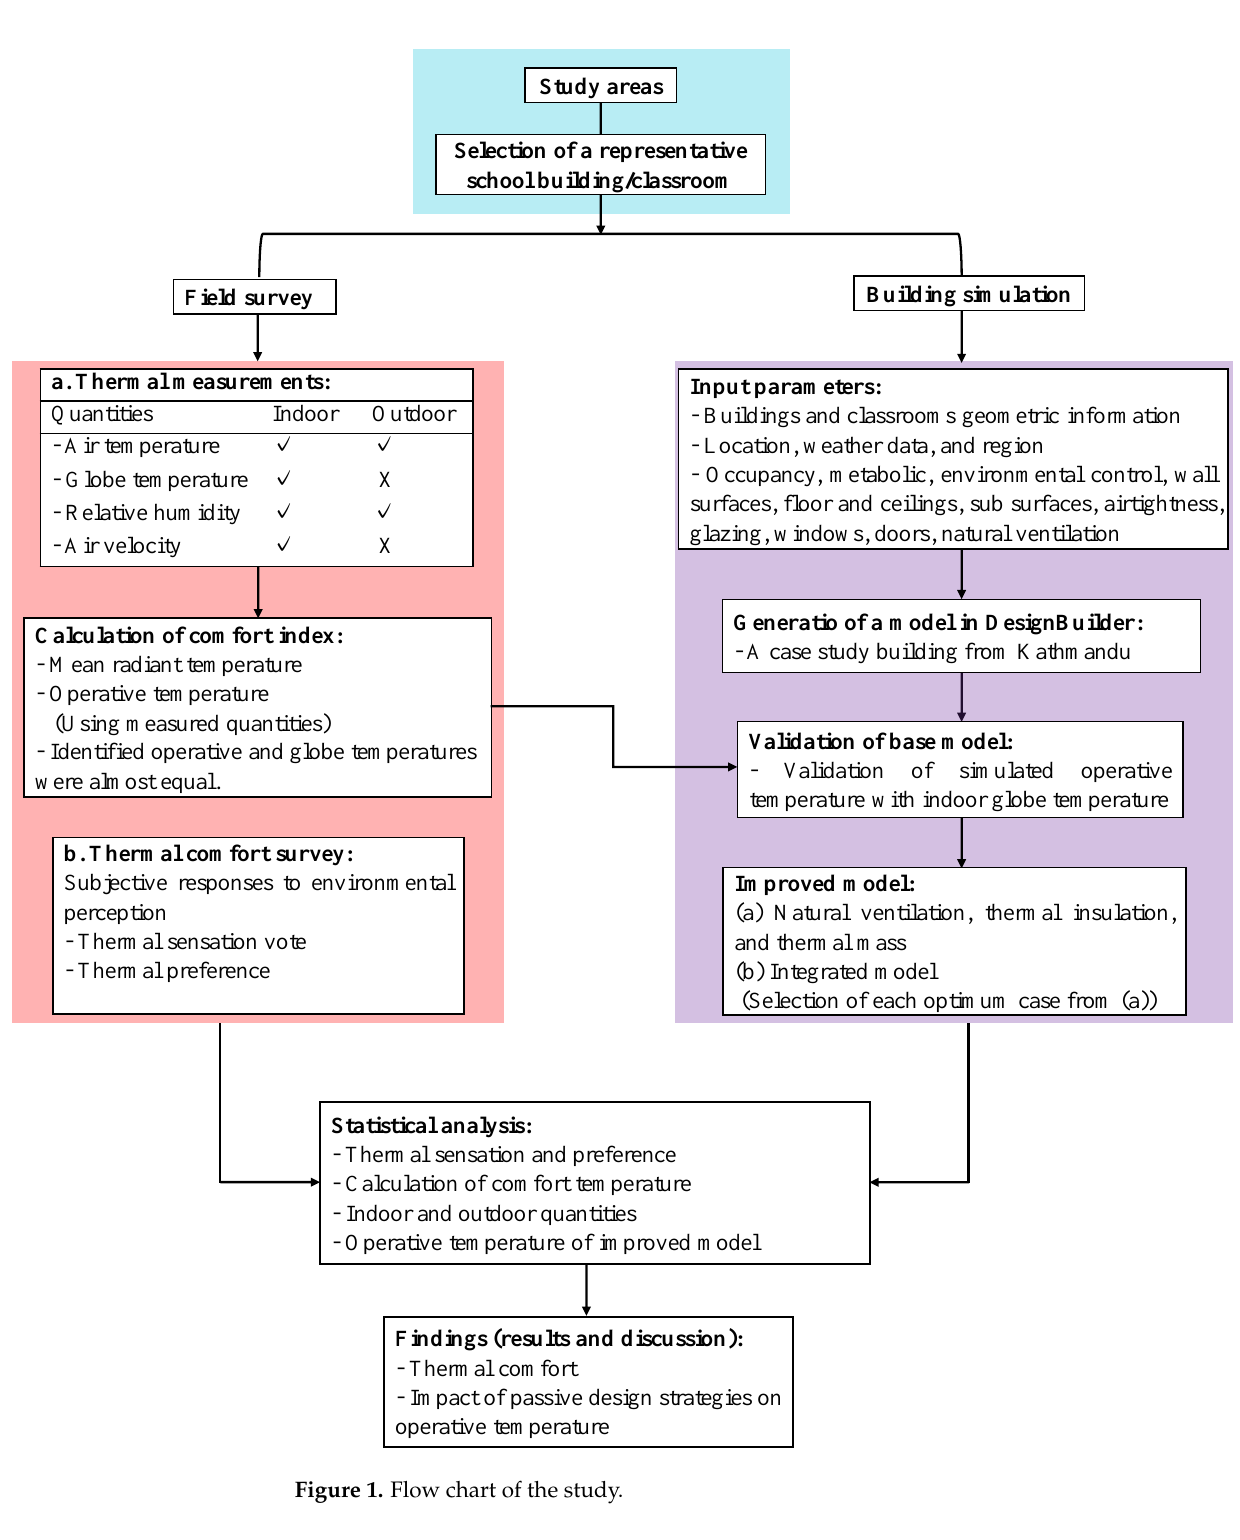
Figure 1. Flow chart of the study.